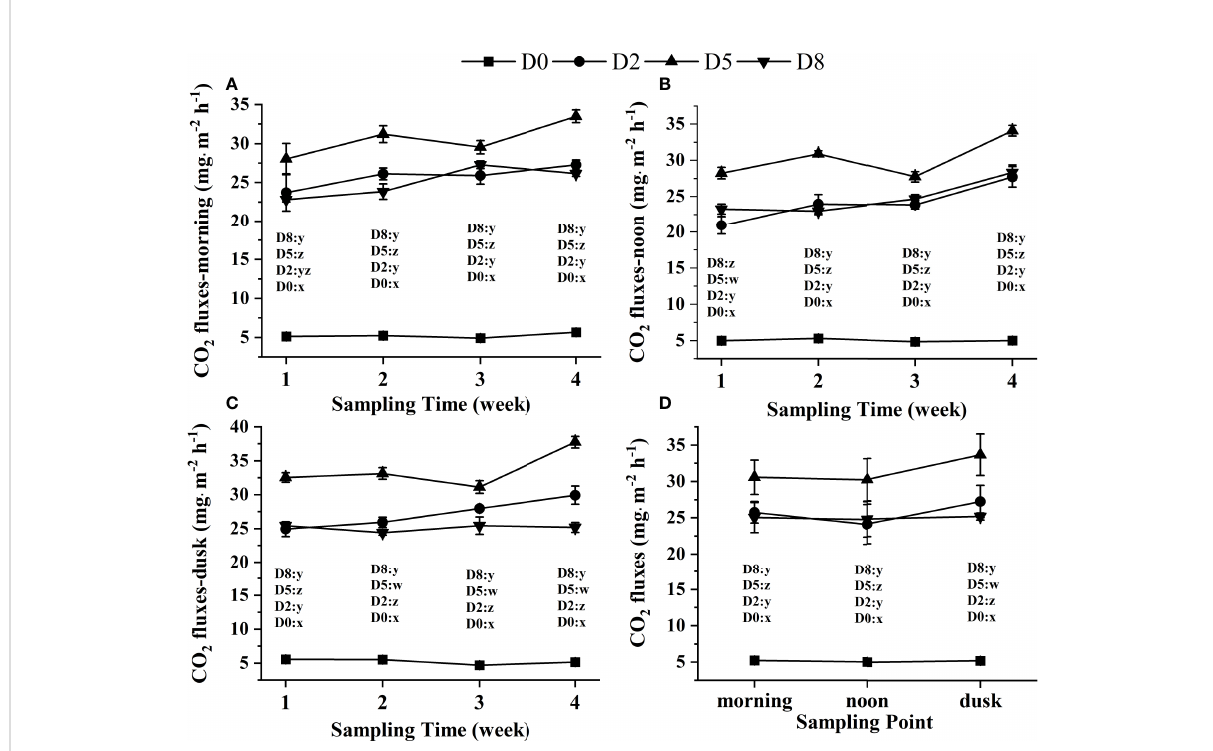
FIGURE 1 Variations of water-air interface CO 2 fl uxes (mg·m -2 h -1 ) at different stocking densities of sea cucumber in the morning (A) , at noon (B) , at dusk (C) and at different times of one day (D) during the experiment. The data are means ± S.D. and bars represent standard deviation. D0: control group; D2: 2 ind./tank; D5: 5 ind./tank; D8; 8 ind./tank. Different letters x, y, z and w represented signi fi cant differences among different densities ( P <